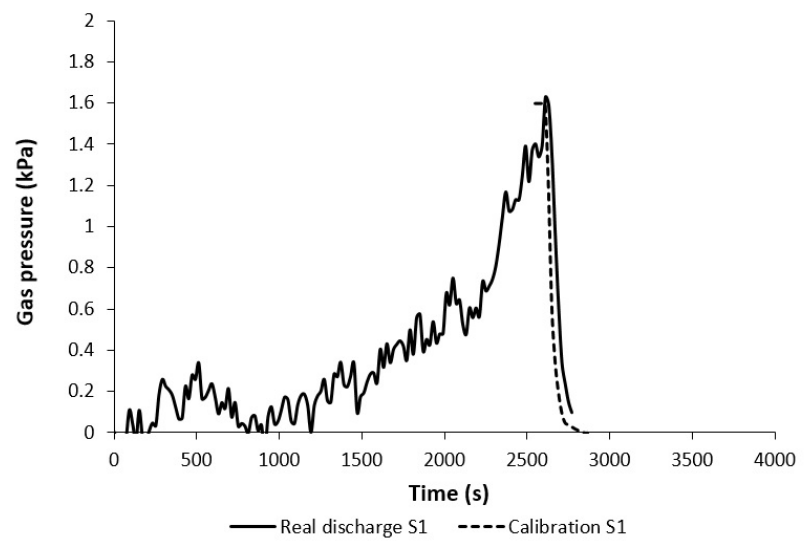
Figure 4. Comparison between the real discharge at S1 and the model calibration in the same borehole.